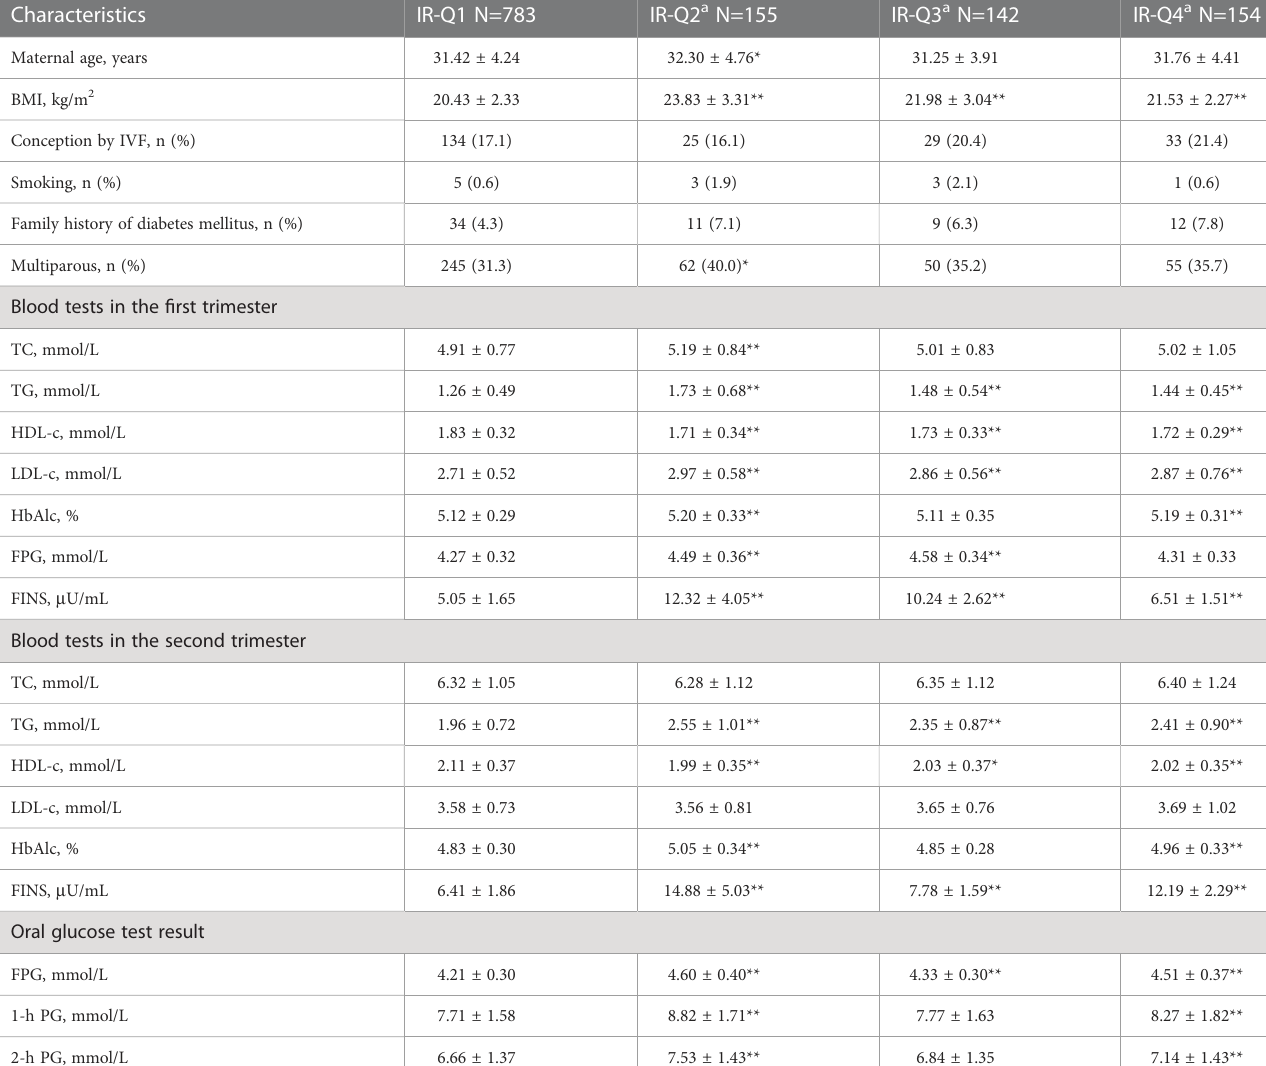
TABLE 3 Maternal characteristics, lipid pro fi les and glucose metabolism indices in different QUICKI subgroups.